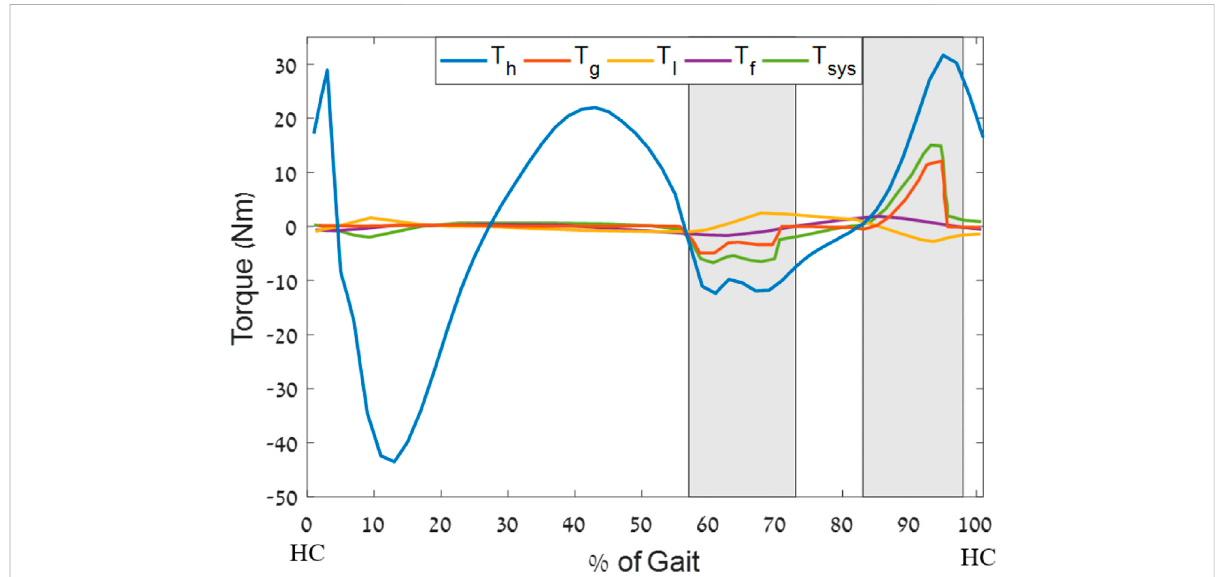
FIGURE 6 Optimal torque pro fi le example for a 50% harvesting level (generator no. 323218), where T h is the standard human walking gait torque pro fi le (Winter,2009)scaledfor an83-kghuman, T g istheoptimalgenerator torquepro fi lethatisapplied totheknee, T I isthetorque feltbytheuserdue to themomentofinertia, T f isthefrictionbrakingtorque,and T sys isthetotaltorquethatthesystemappliestotheknee.Theshadedareasarethephases ofenergyharvesting. Note that we didnot attemptto harvestfor theentire durations of K3and K4 due to variation inthe population. The x-axis is normalized to the percentage of the gait cycle from heel contact (HC) to HC.